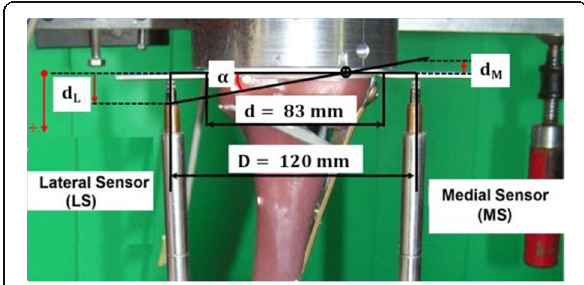
Fig. 3 Valgus-malrotation of the tibia head. The lateral displacement d L was assumed positive and the medial displacement d M was assumed negative. The angle α represented the valgus-malrotation of the tibia head and was calculated by mean of the difference | d L − d M